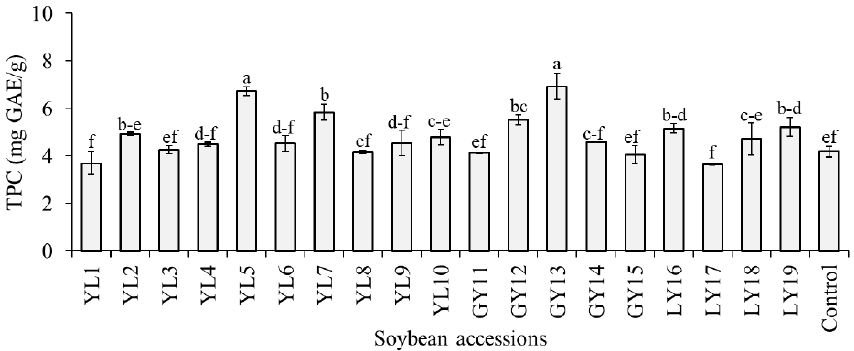
Figure 3. Total phenolic content (TPC) of individual soybeans. Bars with different superscript letters (a–f) represent significantly different values ( p < 0.05).